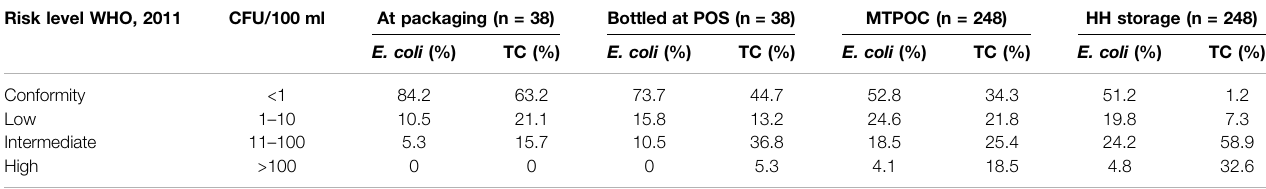
TABLE 1| Microbial result for fi nished bottled waterduring packaging,at point ofsale, municipal tap water at the point ofcollection,and watersample at householdstorage for consumption. Risk level WHO, 2011